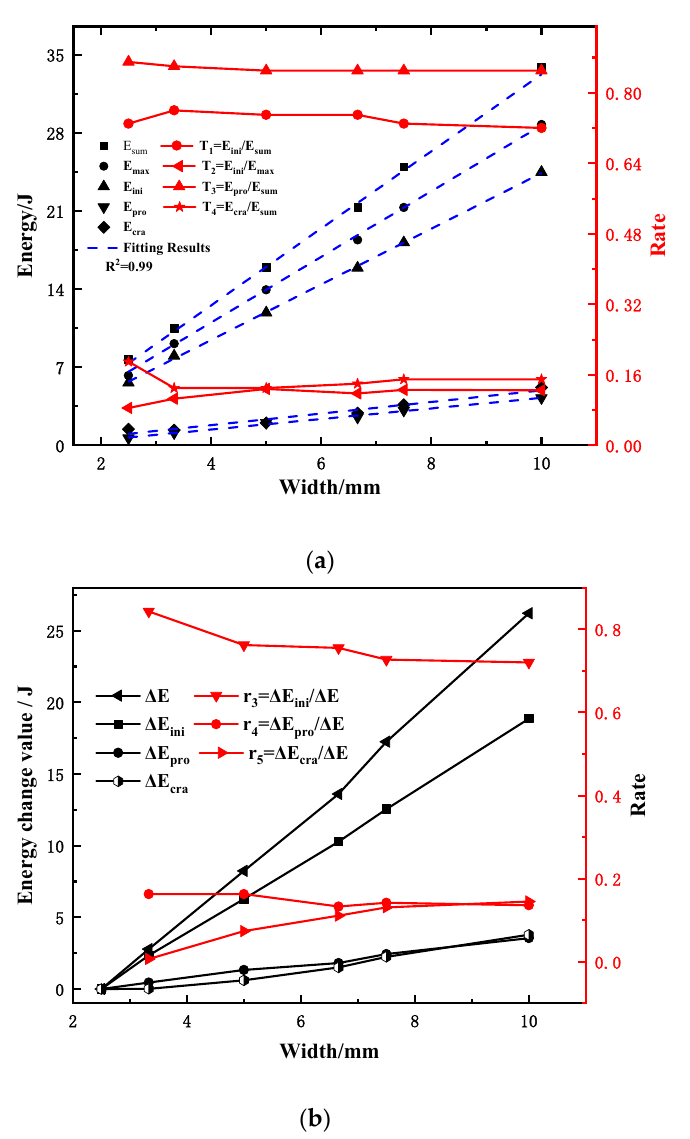
Figure 23. The variation of characteristic energy and corresponding ratio with sample width and fitting results. ( a ) the increment and proportion of the energy of each part; ( b ) the relative increment and proportion of the energy of each part